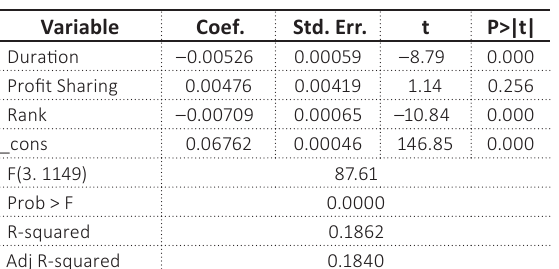
Table 3. OLS regression